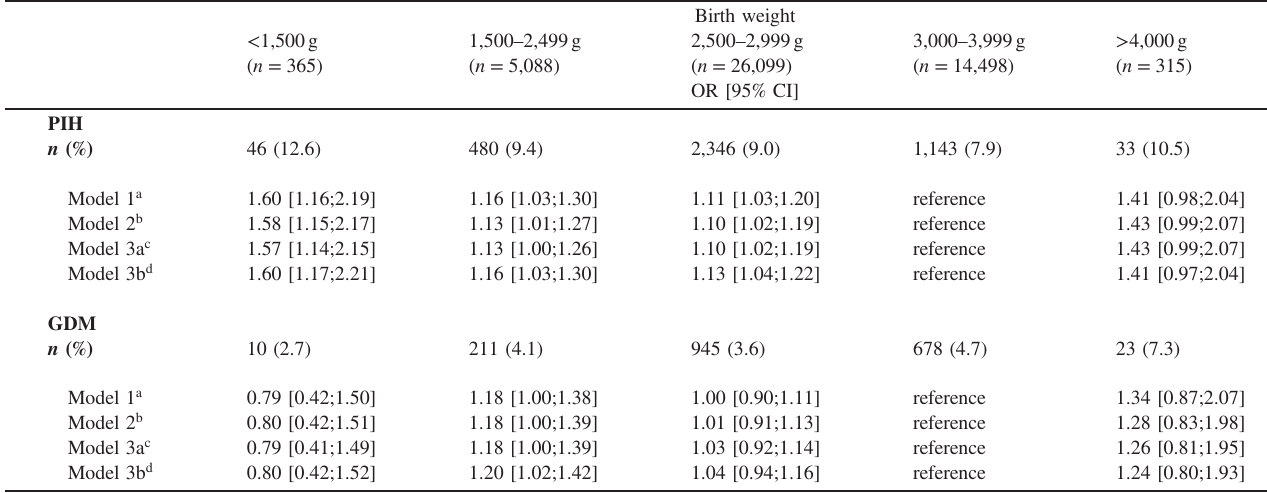
Table 2. Odds ratio for PIH and GDM associated with categories of birth weight based on the partially imputed dataset (covariates imputed except for birthweight, N =